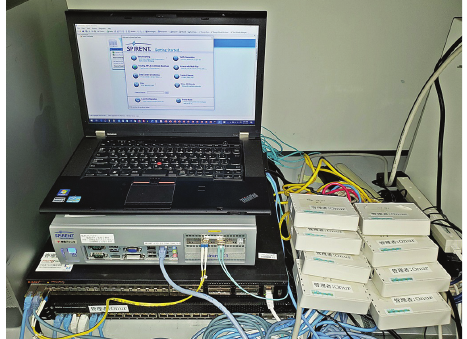
Figure 2. A photo of the